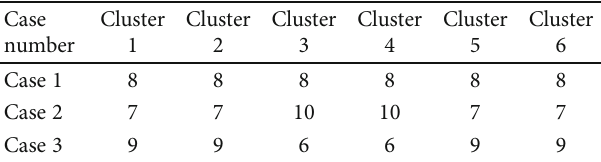
Figure 6: Length (a) and average width (b) of multifracture in a stage with di ff erent cluster Table 3: Perforations of each cluster.